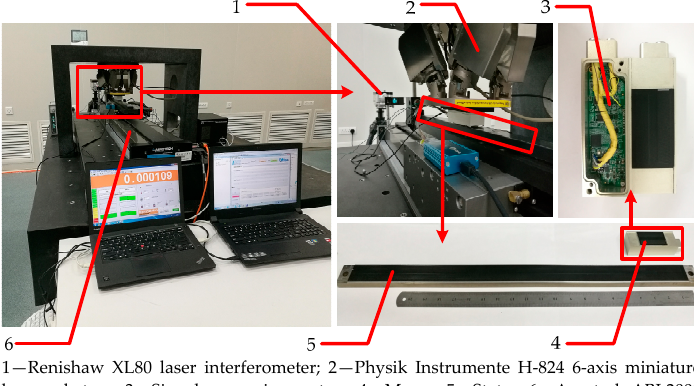
1—Renishaw XL80 laser interferometer; 2—Physik Instrumente H-824 6-axis miniature hexapod stage; 3—Signal processing system; 4—Mover; 5—Stator; 6—Aerotech ABL2000 air-bearing linear stage. Figure 5. Experimental setup employed for evaluating the measurement performance of the prototype VATG sensors manufactured using printed circuit board technology. The displacement measurement errors of the two rows of the prototype VATG sensor individually are shown in Figure 6a as a function of the displacement at 145 points along the entire 600 mm range of the sensor. Here, the error is observed to increase linearly with increasing displacement, and the minimum error is around 6.5 μ m. This type of error is characteristic of all sensors using a repeated periodic structure and that employ an incremental measurement method. However, the double-row capacitive structure can eliminate measurement error accumulated over a small period, as indicated by the measurement error of the prototype VATG sensor over the full range shown by the curve in Figure 6b obtained before optimization. Compared with the measurement errors of the single capacitive rows in Figure 6a, the measurement error has been reduced by 3 μ m at least, and achieves a measurement error of 3.5 μ m at most over the full displacement range, which is much less than the limit E value of 26.845 μ m. Therefore, the prototype VATG sensor can realize absolute displacement measurements.